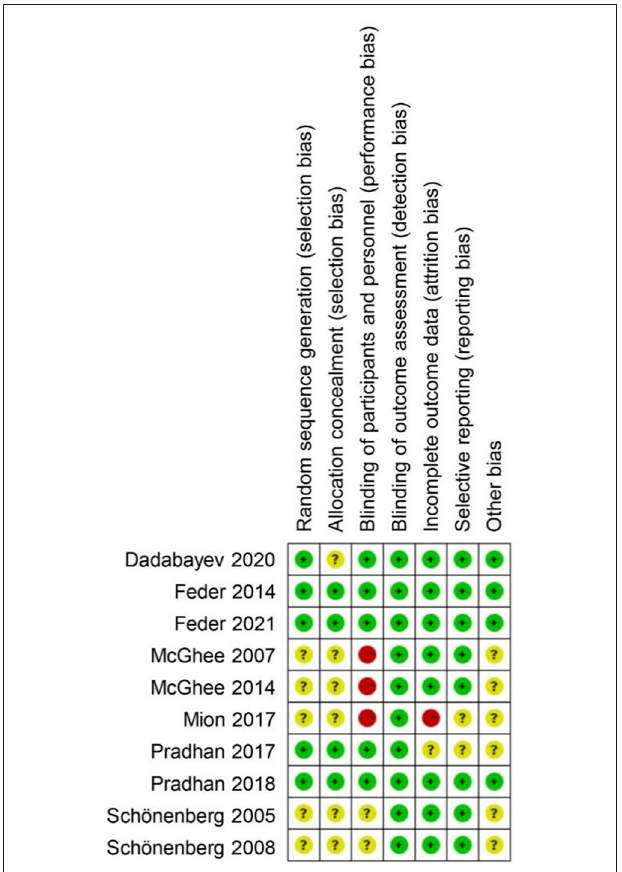
FIGURE 2 | Summary table illustrating risk of bias results for included studies. Green circle, low risk; yellow circle, some concerns; red circle, high risk.